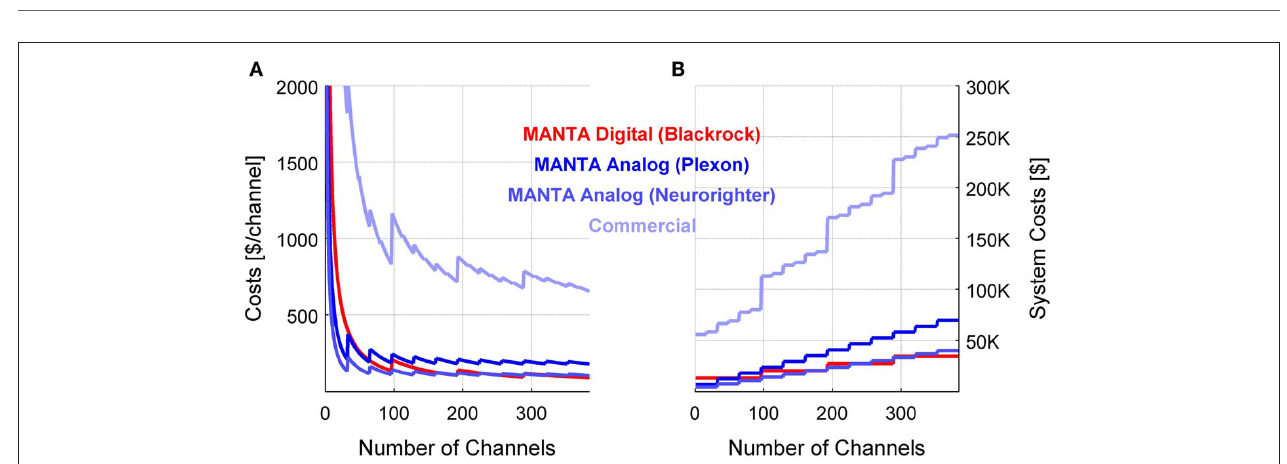
The MANTA/Neurorighter system stays similarly affordable (medium blue). The MANTA/Plexon system is about 50% more expensive, but has the advantage of not requiring any custom hardware components. Commercial solutions usually incur significantly higher costs. To avoid singling out one of the commercial systems, we report here the average and the distribution for a range of systems from various